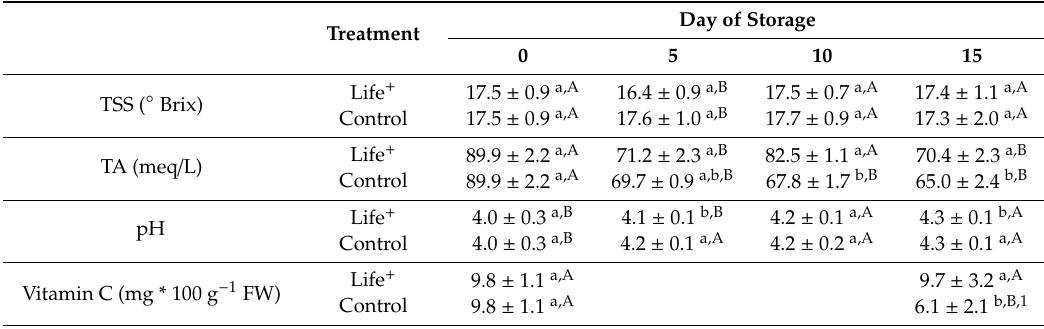
Table 4. The evolution of the quality parameters of sweet cherries (Total Soluble Solids (TSS), Titratable Acidity (TA), and Vitamin C content) stored at 6 ◦ C for 0 to 15